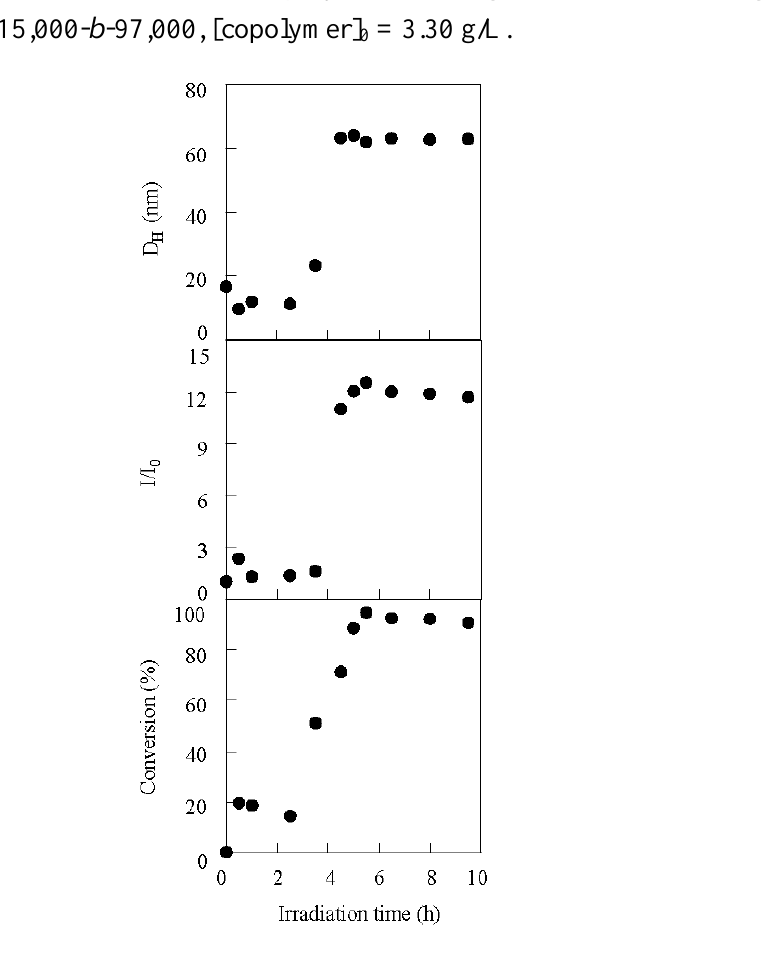
), relative scattering intensity H